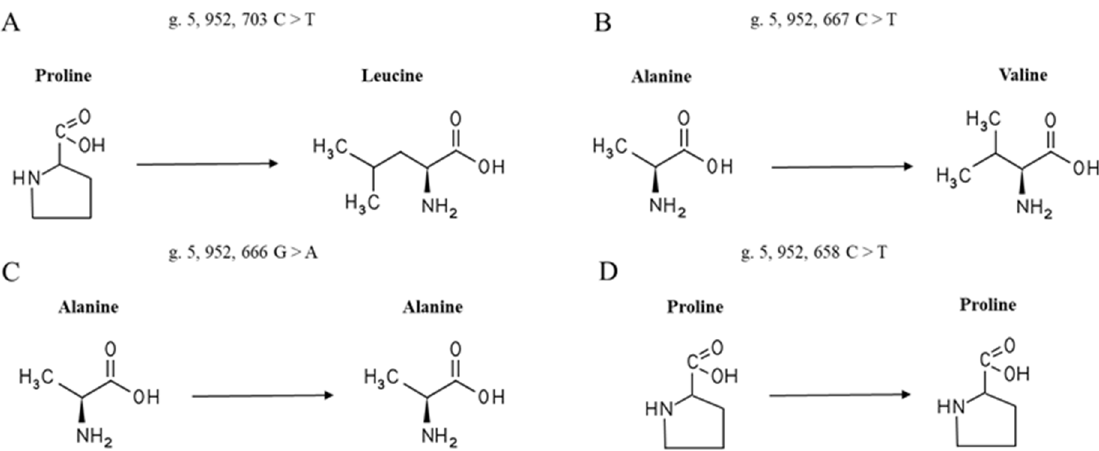
Figure 4. The change in the RXRA amino acid .